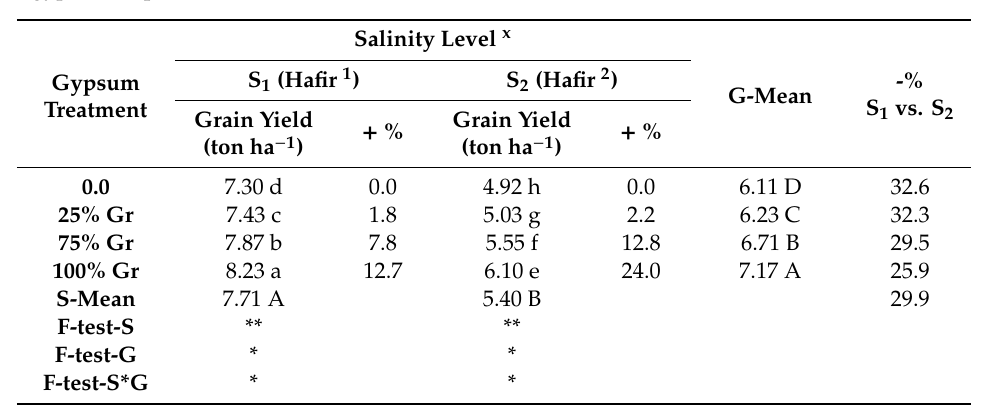
Table 5. Grain yield of wheat (t ha − 1 ) under di ff erent gypsum rates and salinity conditions. Gr: gypsum